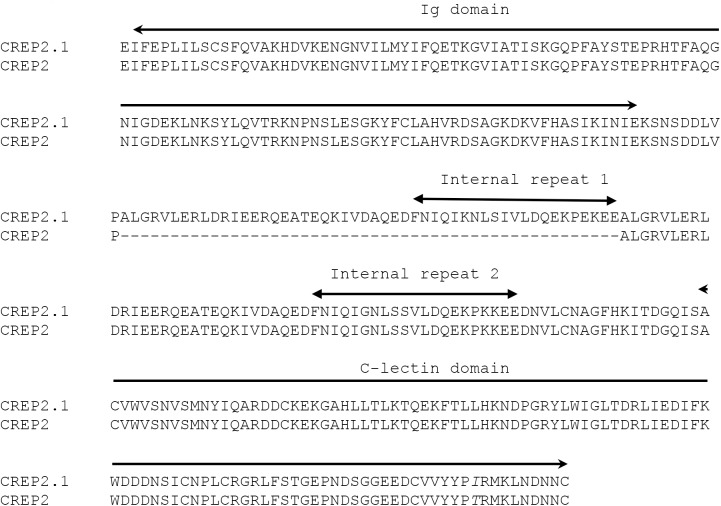
Alignment of a partial C-type lectin-related protein 2 (CREP2.1) sequence with the predicted CREP2 protein.Amino acid sequence predicted from an RNAseq assembly (CREP2; AKS26832.1) [18] is compared to a partial ORF encoding a CREP2, presenting an Ig domain, 2 internal repeat domains and a C-type lectin domain, from BS-90 and NMRI snail cDNA (CREP2.1). CREP2.1 presented an additional 50 aa sequence containing an internal repeat domain (internal repeat domain1) and a single aa difference (italics) when compared to CREP2.